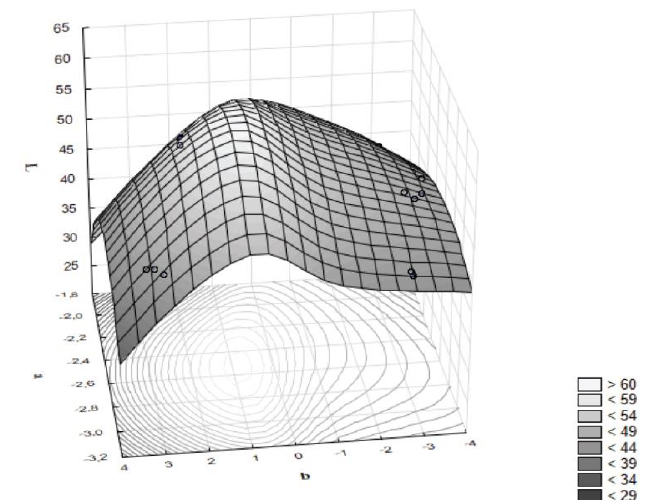
Figure 2. Surface plot of color parameters: L* relative to b* and a*.